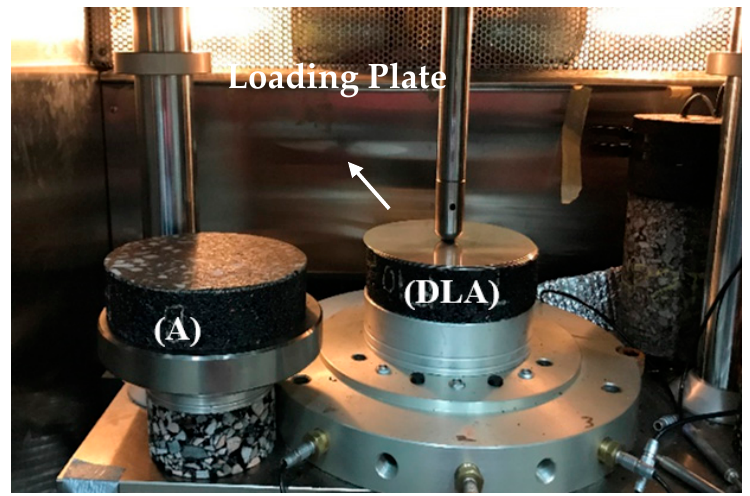
Figure 4. Conditioning method for aged (A) and dynamically loaded aged (DLA) specimens.